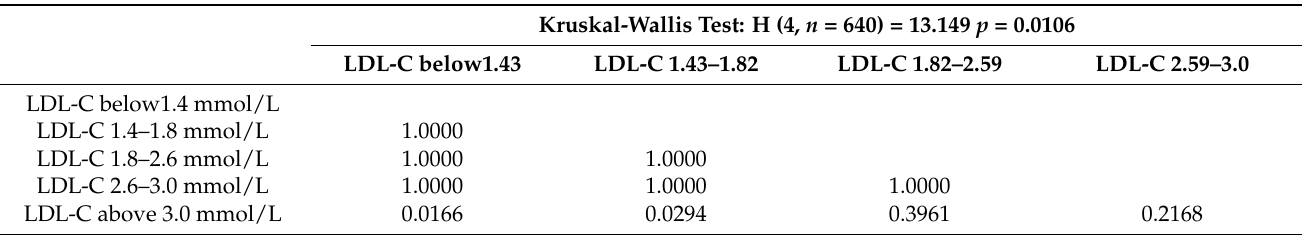
Table 2. Kruskal-Wallis and Dunn’s post-hoc test results for max Troponin-I serum level vs LDL-C.